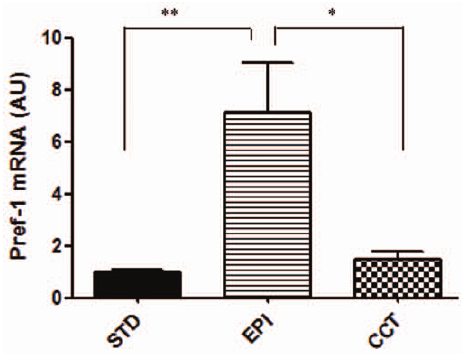
Figure 4. The NPY receptors antagonists prevented the effects of epinephrine on up-regulation of the preadipocyte marker Pref-1 at commitment stage. EBs were treated with insulin (STD), insulin plus epinephrine (EPI) or insulin plus EPI and NPY receptors antagonists (CCT) from day 7 to day 17. RNA was isolated after 10days of treatment and the expression of preadipocyte marker Pref-1 was measured by RT-PCR. b -actin expression was used as an internal control. Values are from three separate experiments each performed in triplicate*p , 0.05, **p , 0.01.